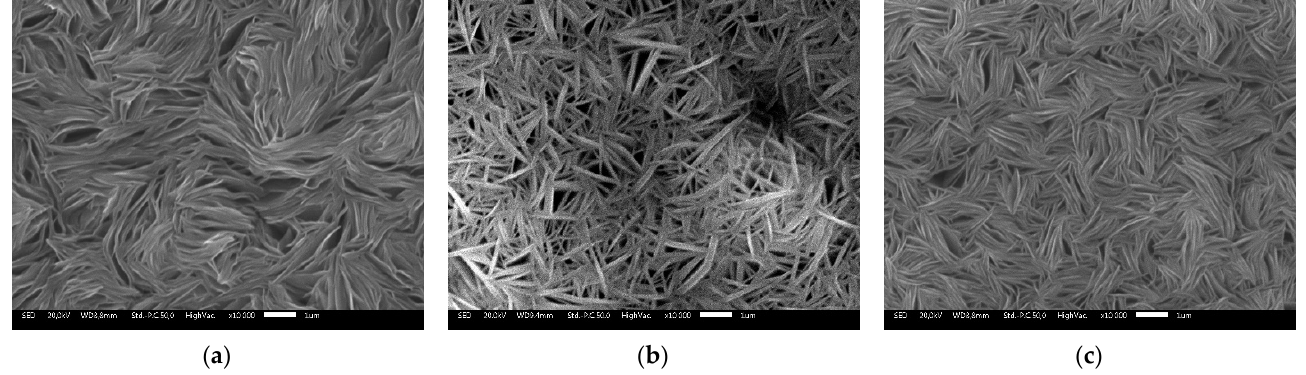
Figure 6. SEM images of the top-view of the as synthesized samples: ( a ) C10-1, ( b ) C10-4.5, and ( c ) C10-9.